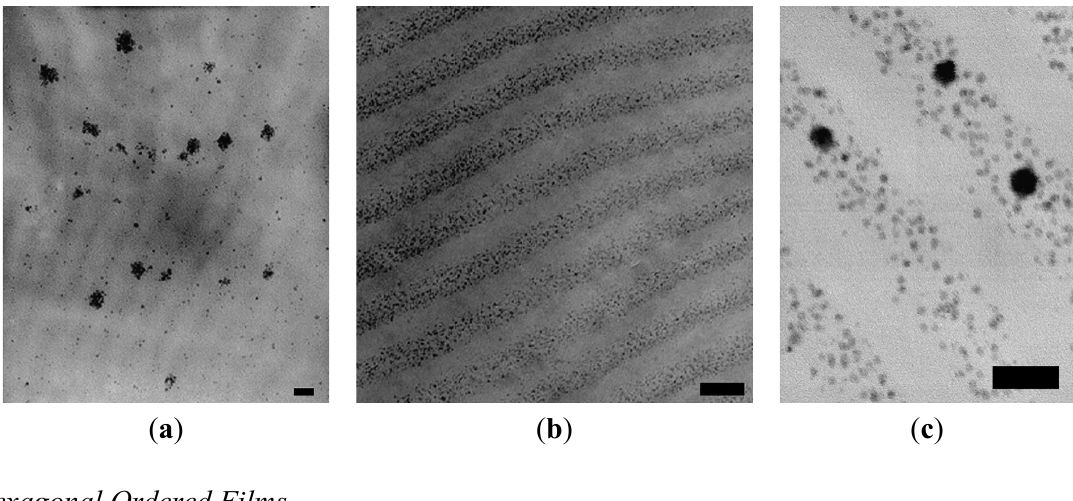
of iron/g P2VP; sample heated to 195 °C for 24 h, scale bar = 50 nm; ( b ) TEM